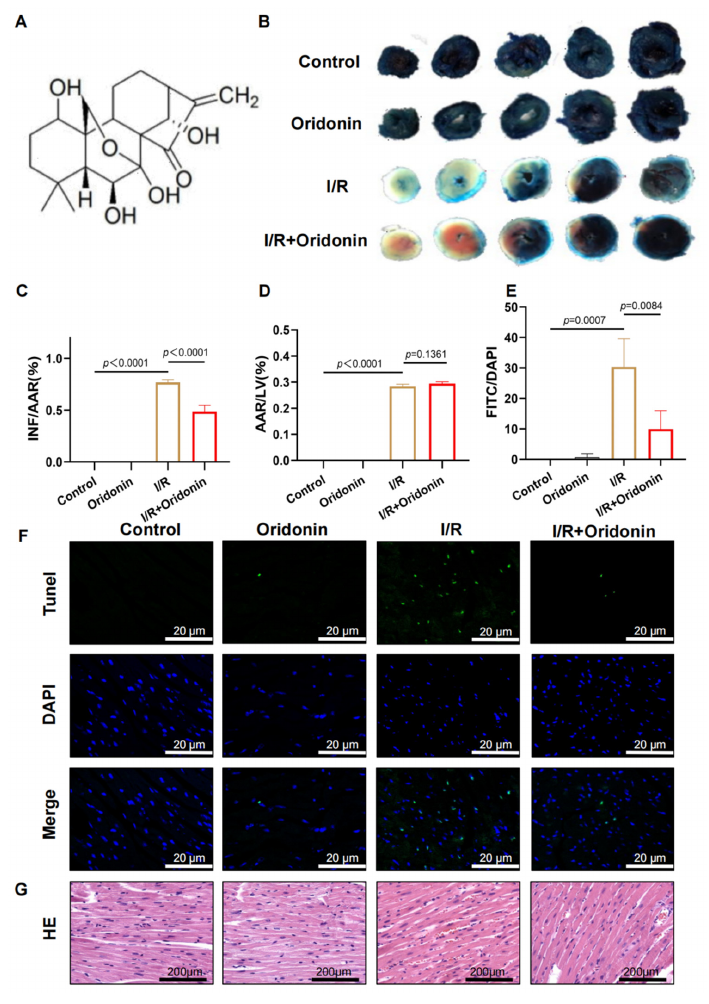
Figure 1. Oridonin reduced infarct size and improved the morphology of cardiomyocytes. ( A ) Chemical formula of oridonin. ( B ) Cross-sections of mouse left ventricles (LV) stained with Evans Blue/TTC. ( C ) Histogram of the INF/AAR results in ( B ). ( D ) Histogram of the AAR/LV results in ( B ). ( E ) Histogram of the number of TUNEL-positive cells based on ( F ). ( F ) Apoptosis of tissue cells was observed by TUNEL staining. The I/R group exhibited significantly higher cardiomyocyte pyroptosis (by approximately 30%) than the control group, and the number of TUNEL-positive cells was significantly reduced after oridonin pretreatment. ( G ) Representative H&E staining. The dose of oridonin pretreatment was 15 mg/kg. All samples were obtained from C57BL/6 mice. In all cases, the data are expressed as the mean ± SD.